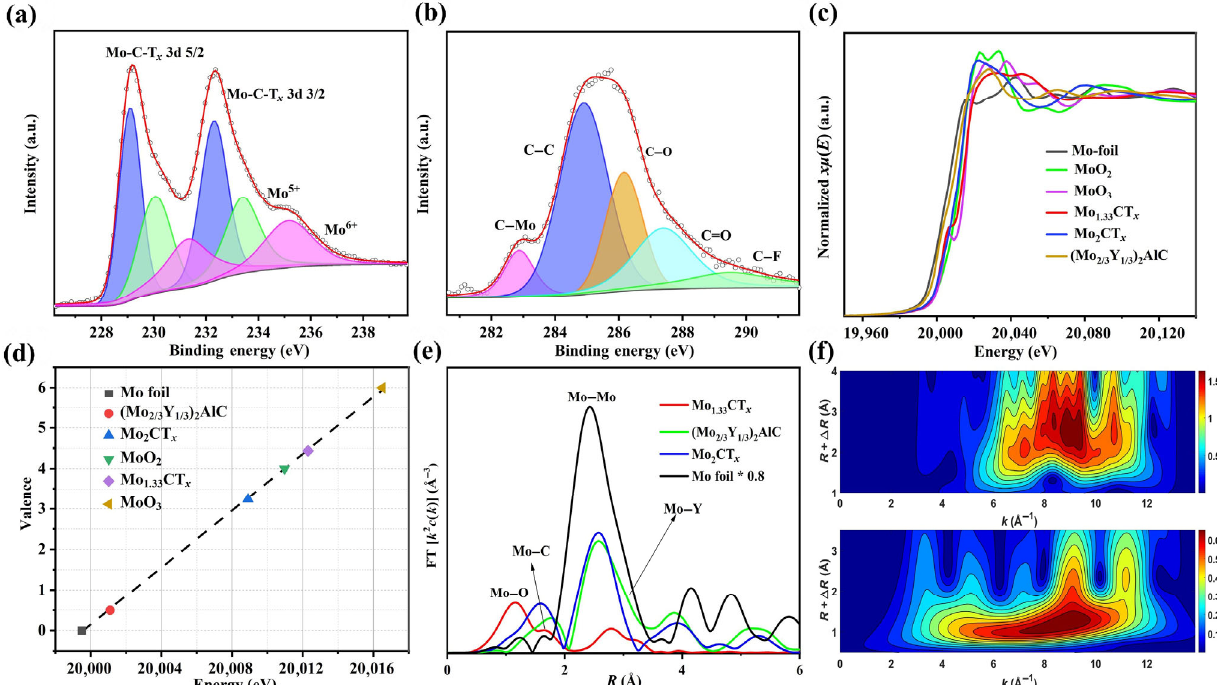
Figure 2 X-ray spectroscopic structure characterization of Mo 1.33 CT x . (a) and (b) High-resolution XPS spectrum of Mo 3d and C 1s for Mo 1.33 CT x . (c) Normalized XANES spectra of Mo K-edge for Mo foil, MoO 2 , MoO 3 , Mo 2 CT x , (Mo 2/3 Y 1/3 ) 2 AlC, and Mo 1.33 CT x . (d) Fitted chemical valences for Mo atom in Mo 2 CT x , (Mo 2/3 Y 1/3 ) 2 AlC, and Mo 1.33 CT x . (e) Fourier-transformed Mo K-edge EXAFS spectra for Mo foil, Mo 2 CT x , (Mo 2/3 Y 1/3 ) 2 AlC, and Mo 1.33 CT x . (f) WT of (Mo 2/3 Y 1/3 ) 2 AlC (above) and Mo 1.33 CT x (below),